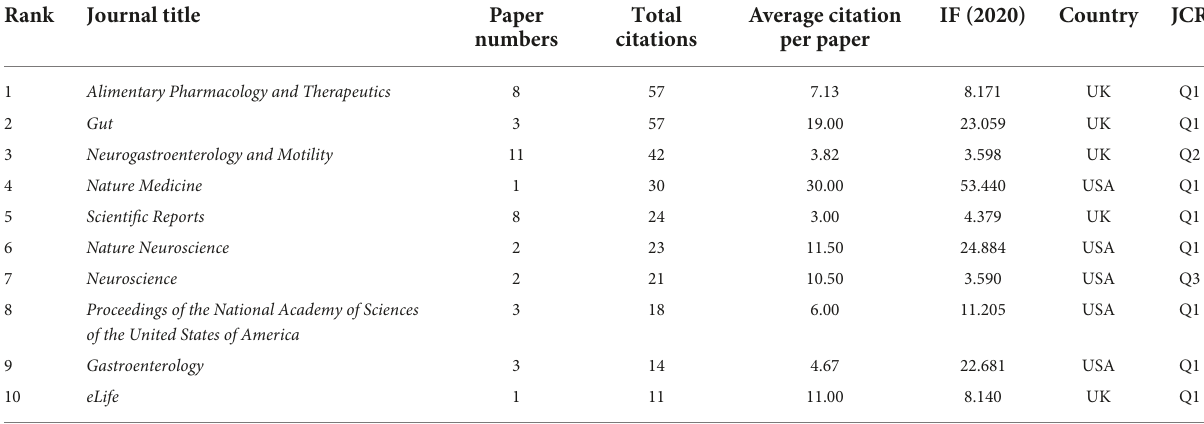
TABLE 1 The top 10 most-cited journals for gut microbiota research in the pain field.